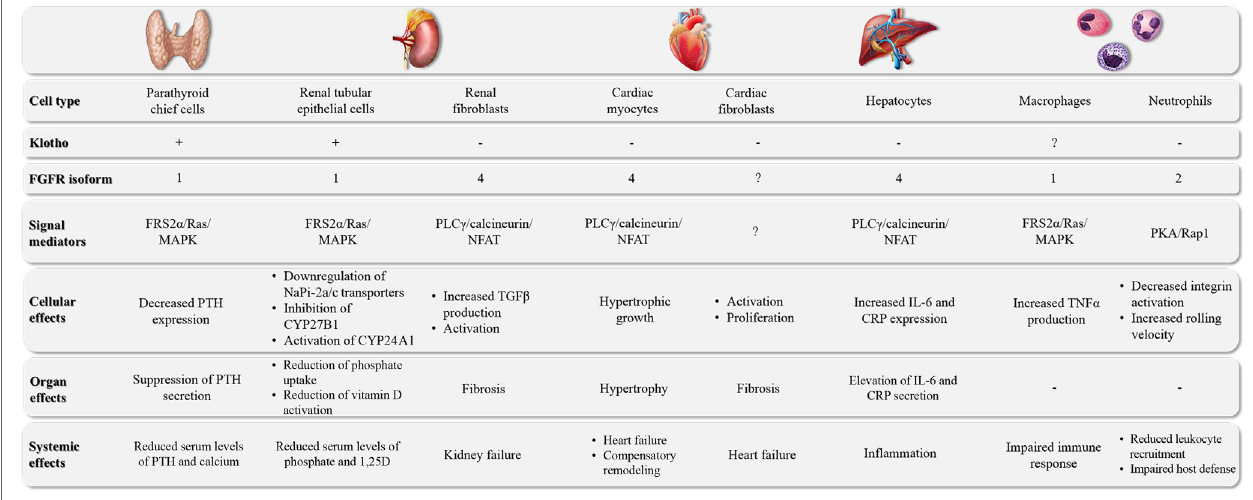
FiGURe 1 | The major target organs of FGF23. FGF23 can directly target different cell types in a variety of organs. The underlying molecular pathways can differ in their requirement for klotho as well as the involvement of specific FGFR isoforms and downstream signal mediators, leading to cell type-specific events and tissue-specific